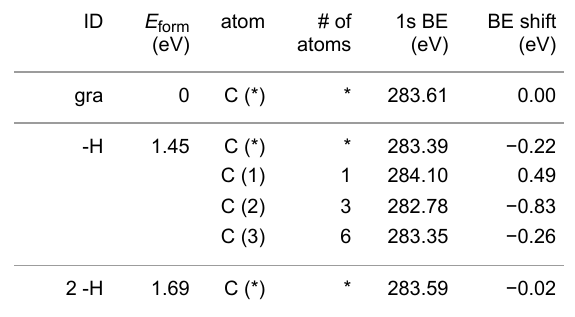
Table 2: Calculation results for the functionalized graphene structures. The columns show: system identifier; formation energy of the